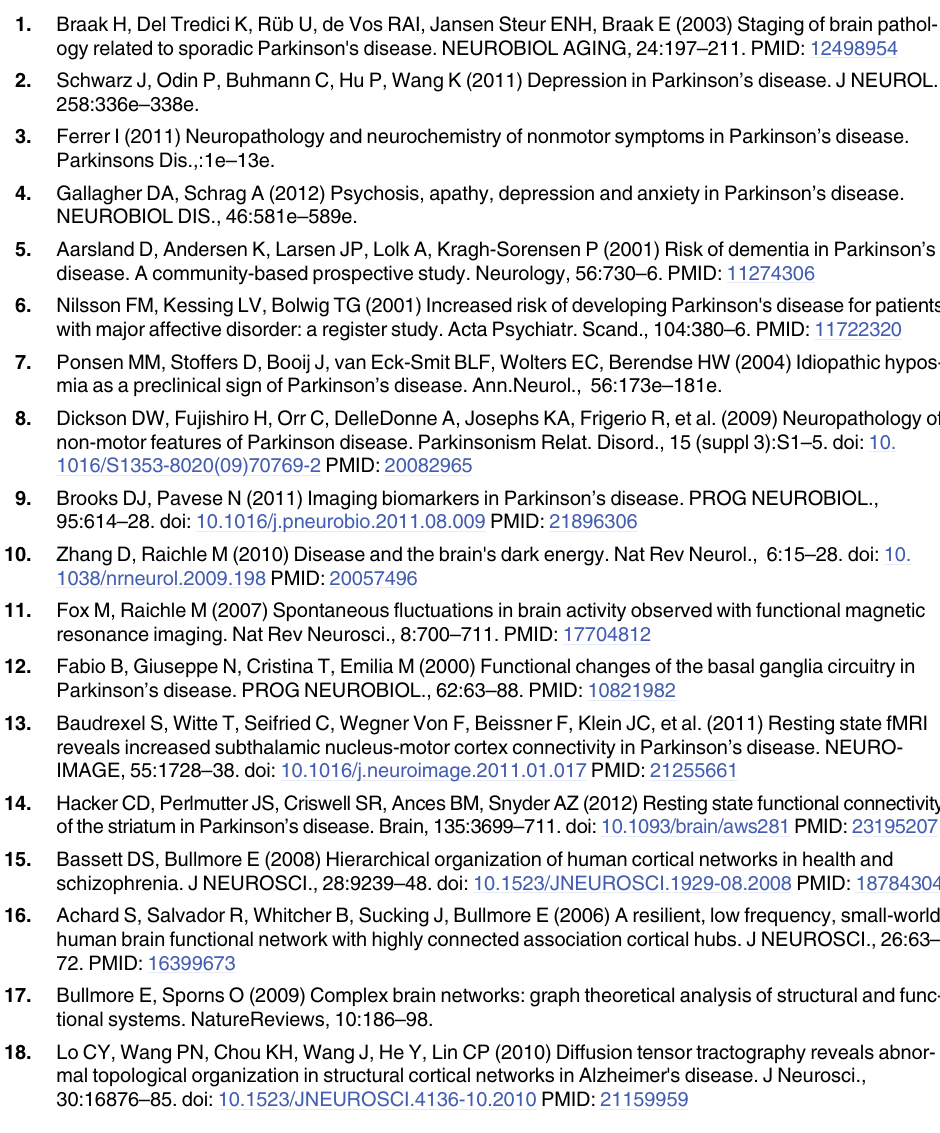
S2 Table. Decreased functional connectivity in PD patients compared with normal controls (p < 0.002, uncorrected). S3 Table. The mean values of global efficiency and local efficiency in both normal controls and PD patients